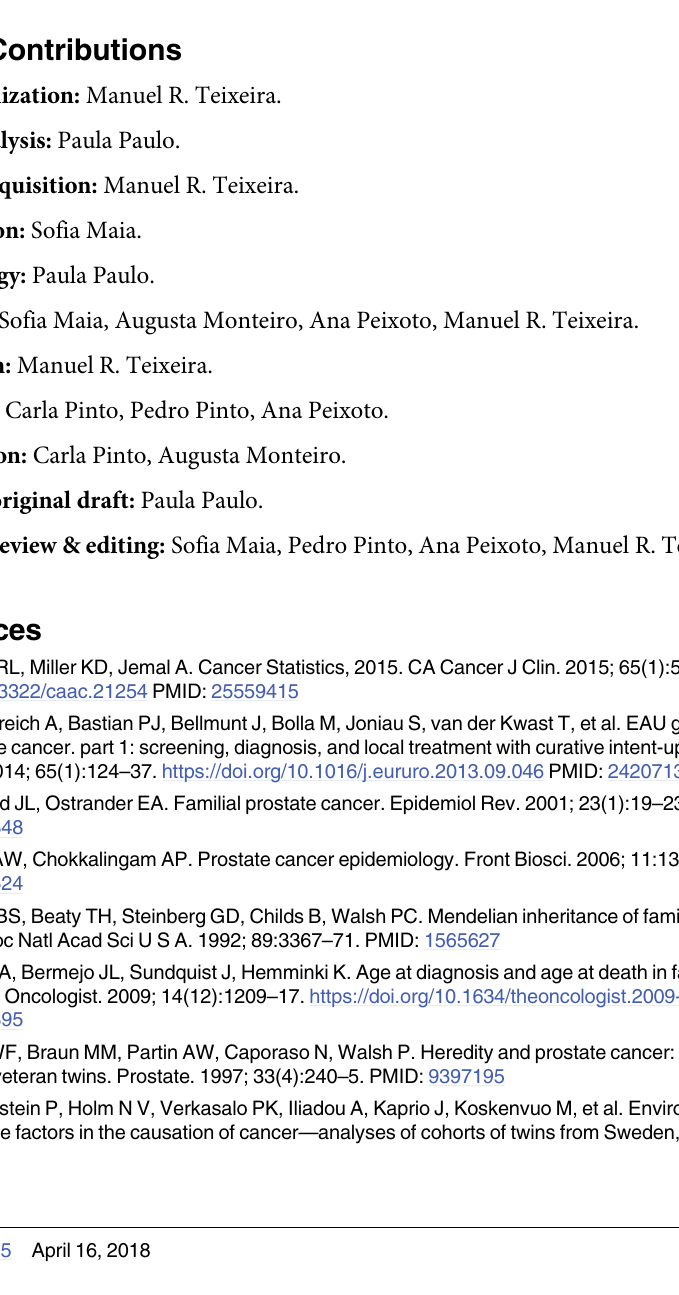
S5 Table. Clinicopathological associations between mutation carriers and non-carriers considering homogeneous sample